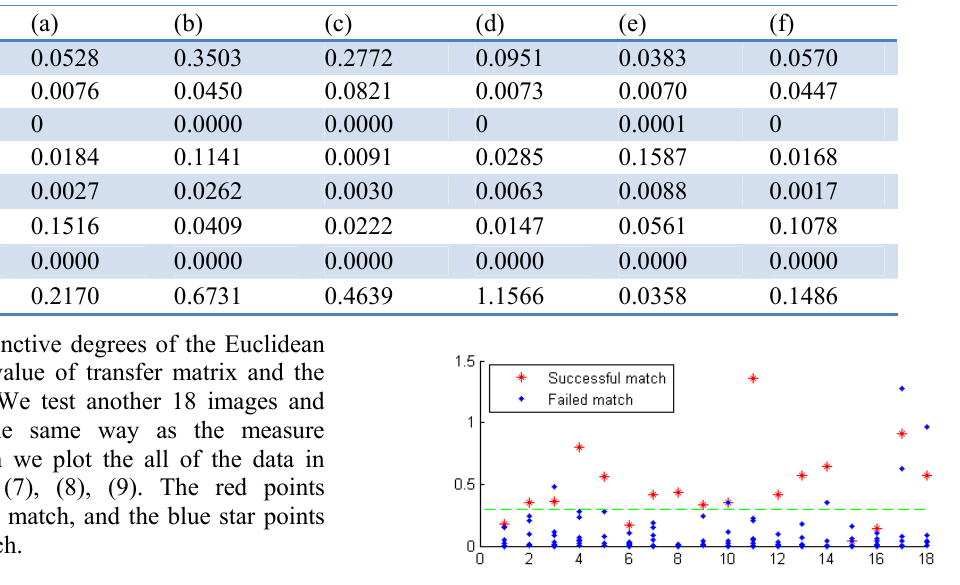
Table 7 Final result of the